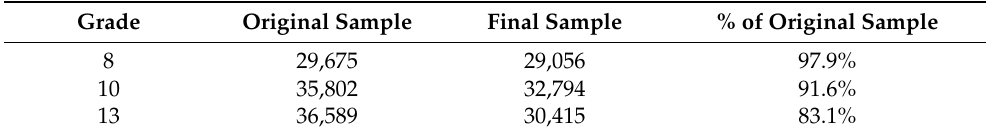
Table 1. The three considered